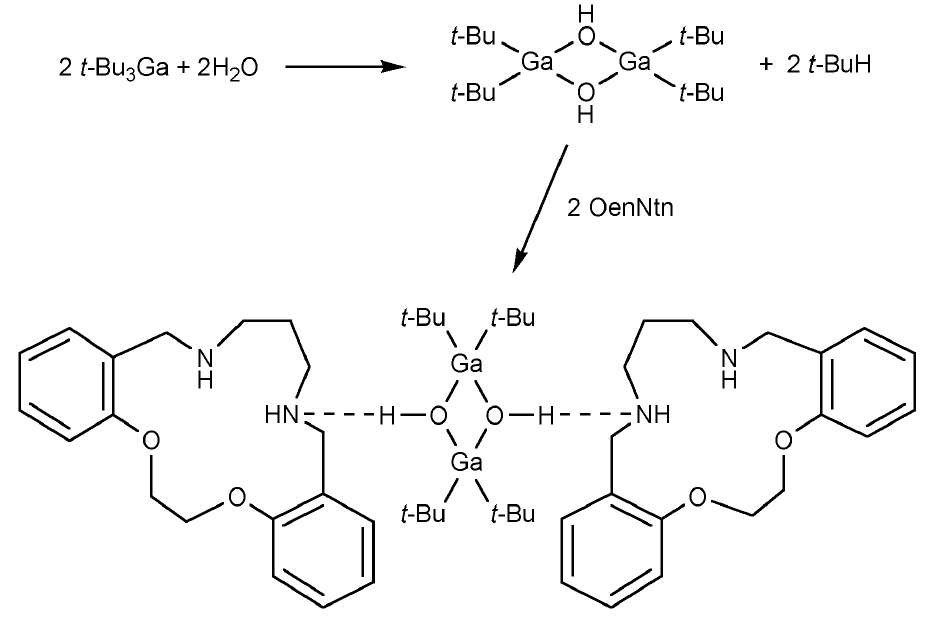
(cid:215) 2 Ga( m -OH)] 2 2